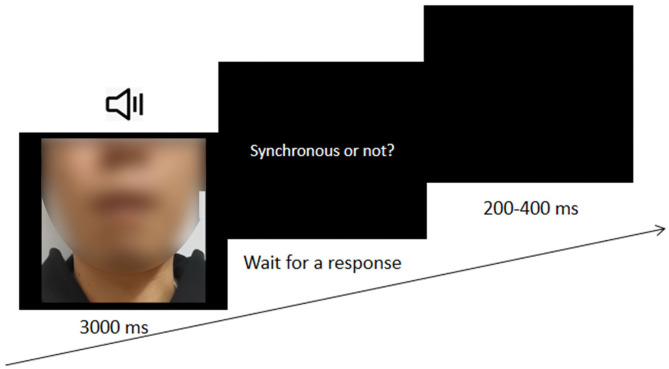
The procedure of Experiment 2.